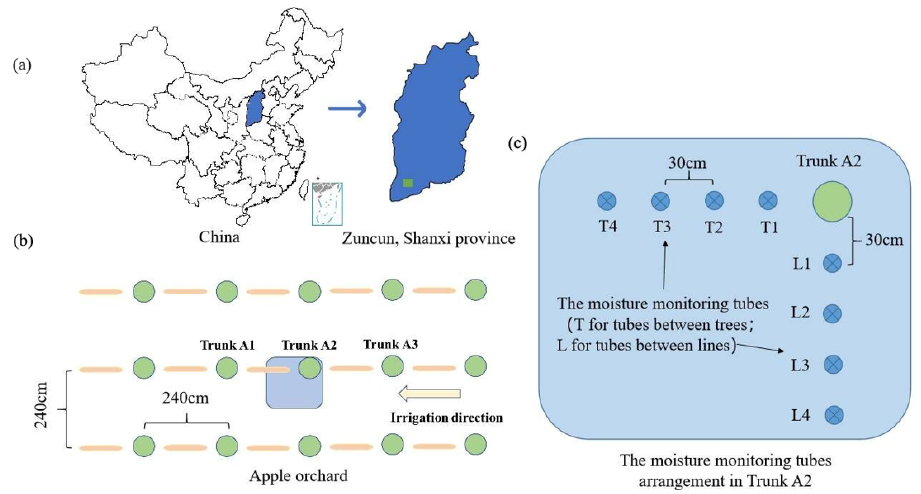
Figure 1. Schematic diagram of the experiment: ( a ) location of the study site; ( b ) general situation of the experimental apple orchard; and ( c ) arrangement of moisture-monitoring tubes.